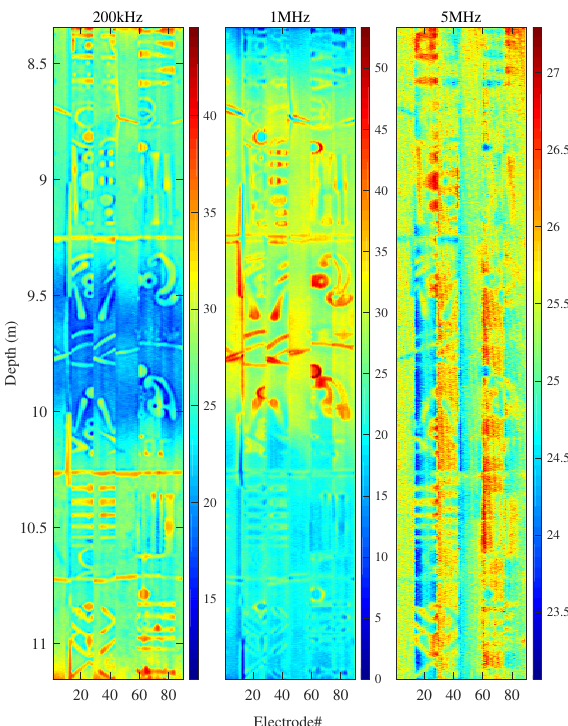
Figure 12. The imaging result of borehole wall patterns with UMMAI sample phases in the first test, while the borehole is filled with oil-based